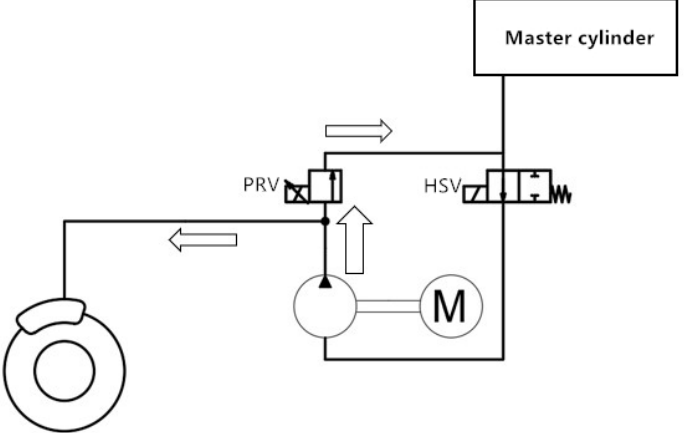
Figure 6. Working state of RBU during active pressurization.